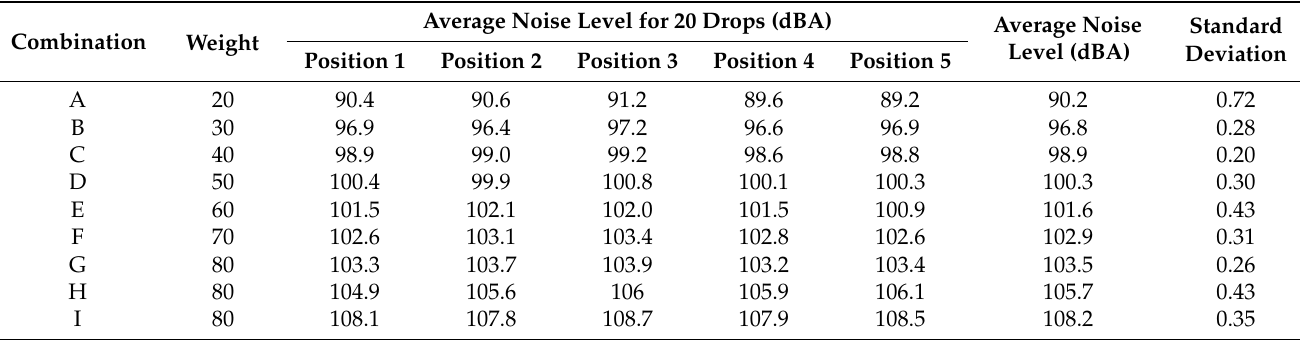
Table A2. Detailed data of four selected groups (snatch).